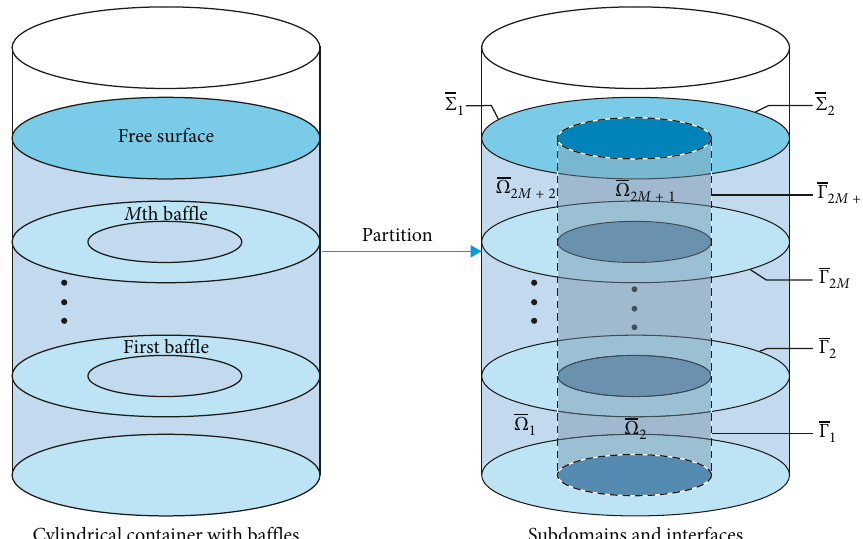
Figure 2: Partition of the liquid domain developed by Wang et al. [9].